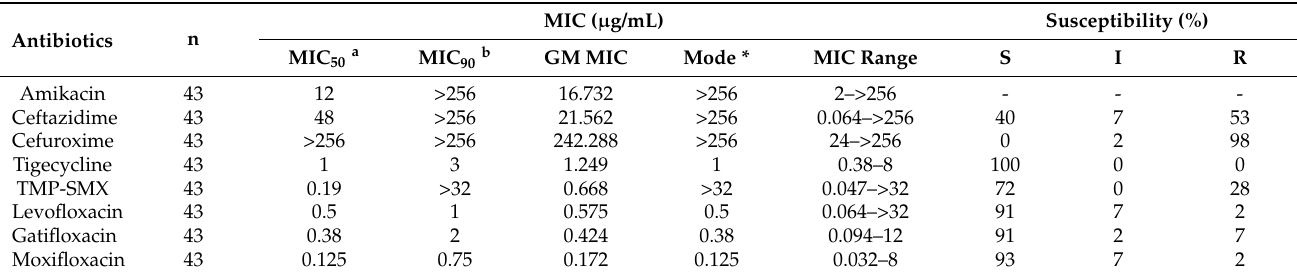
Table 1. Minimum Inhibitory Concentrations and Antibiotic Susceptibilities of Stenotrophomonas maltophilia Isolates.